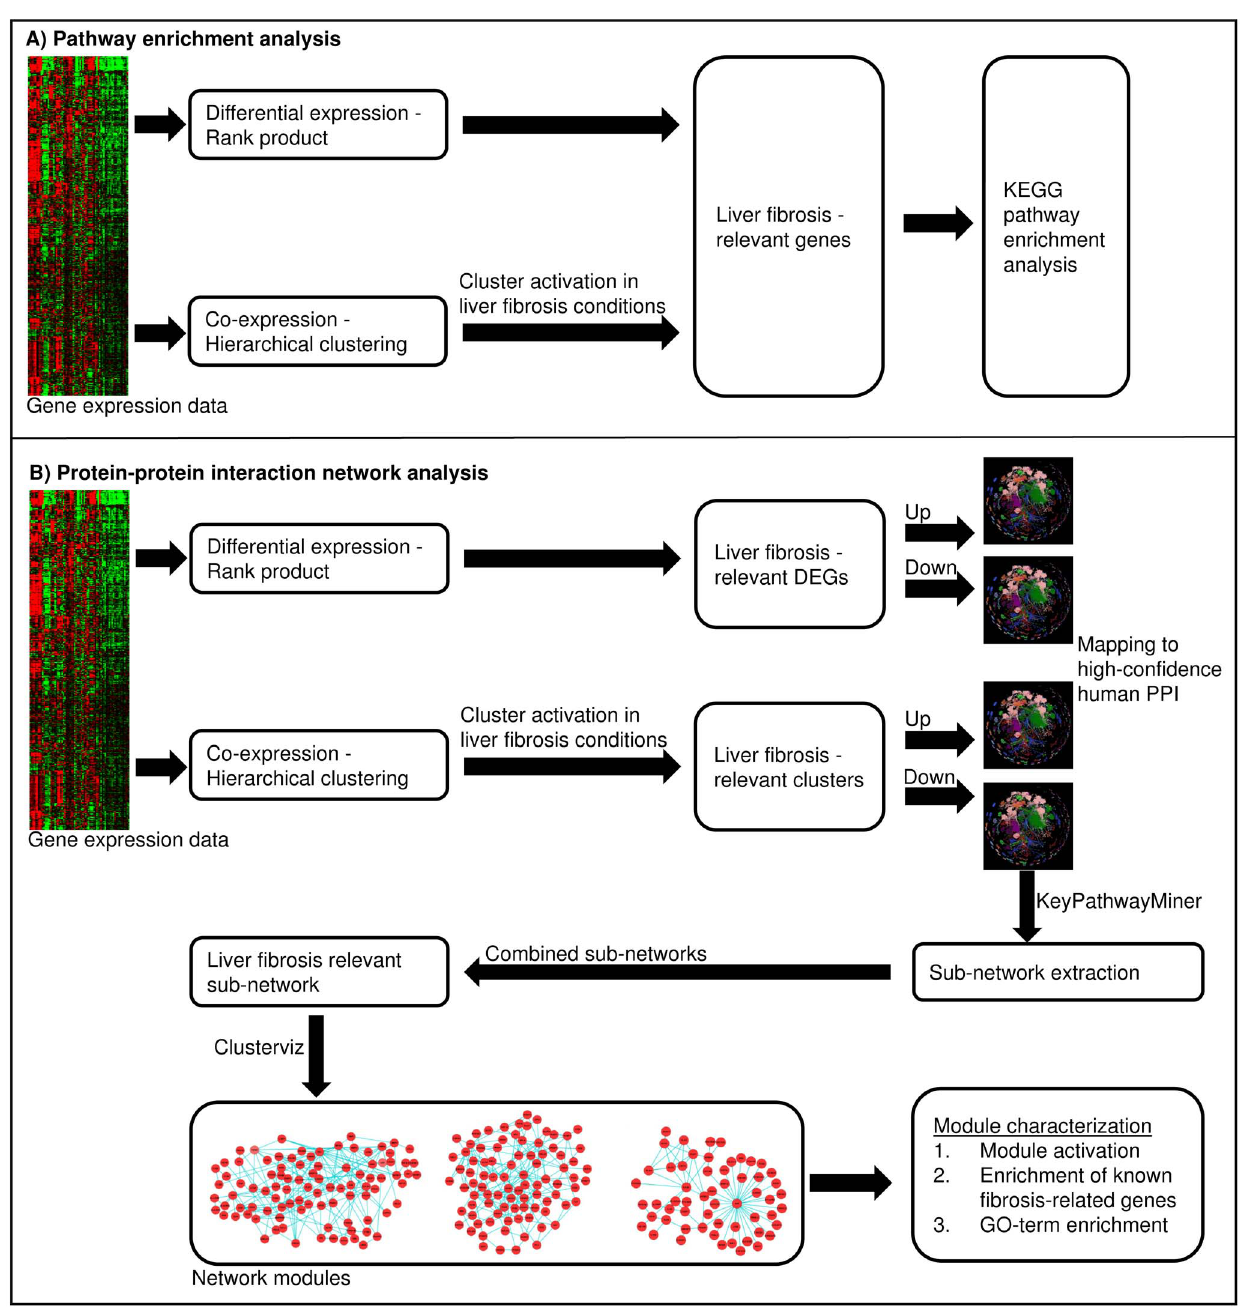
Figure 1. Workflow used in this study to identify pathways and networks associated with liver fibrosis.